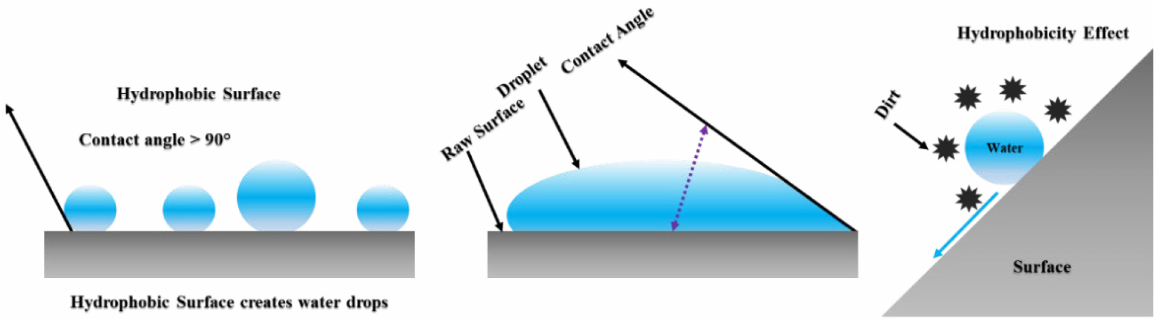
Figure 2. Hydrophobic surface as anti-dust